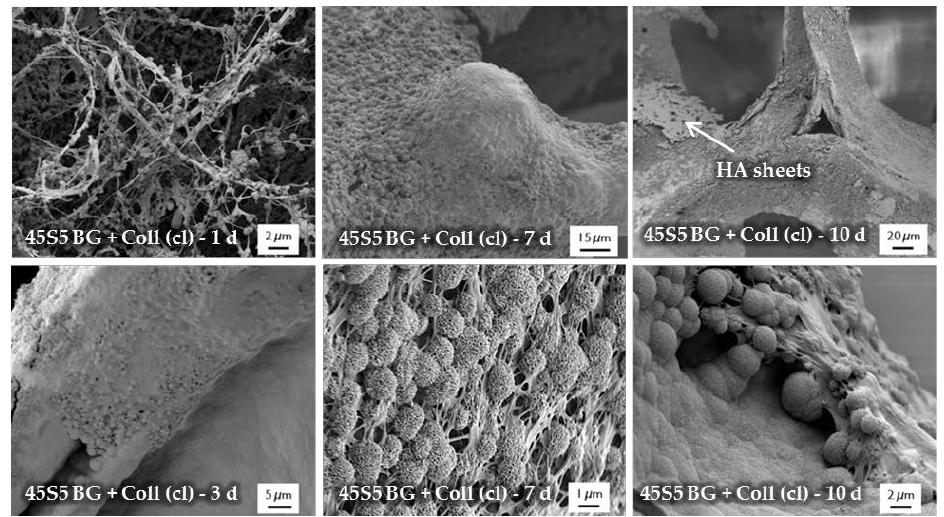
Figure 8. SEM images of collagen (Coll)-coated 45S5 BG-based scaffolds (cl) after immersion in SBF for 1, 3, 7, and 10 days (at different magnifications). The formation of a mineralized collagen layer can be observed.